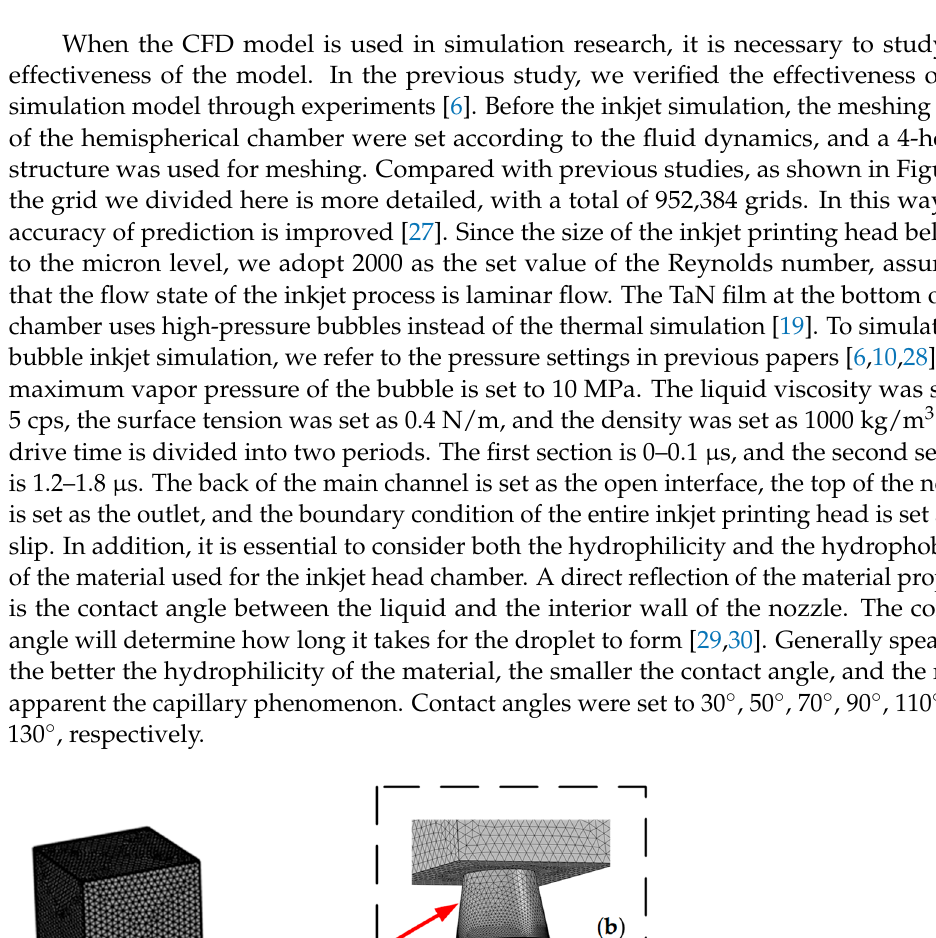
6 of 16 Figure 3. The structural parameters of the hemispherical chamber inkjet head. ( a ) The three-dimen- sional structure of the hemispherical chamber; ( b ) The side view of the hemispherical chamber; ( c ) The back view of the hemispherical chamber. Table 1. The design parameters of the hemispherical inkjet head. Structural Parameters Value (µm) Nozzle top diameter 15 Nozzle bottom diameter